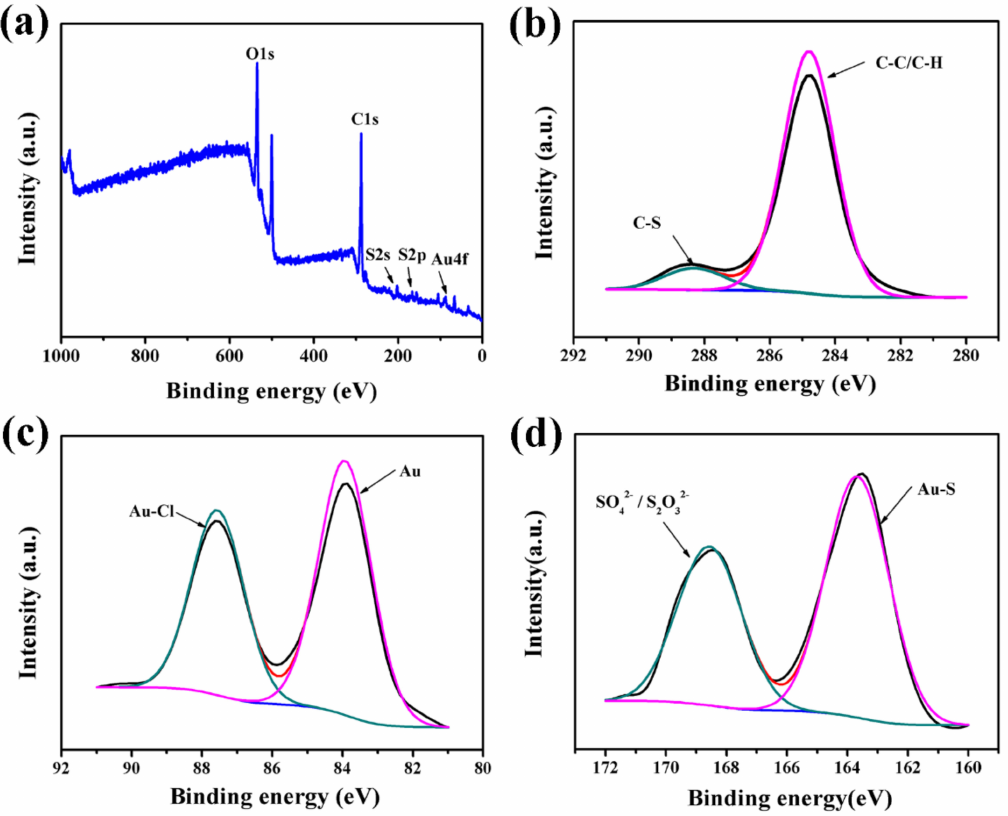
Figure 3. XPS spectra of Au-HET: ( a ) the peaks of Au 4f, S 2p, S 2s, C 1s, and O 1s; ( b ) the peaks of C 1s, C-C/C-H and C-S; ( c ) the peaks of Au; ( d ) the peaks of